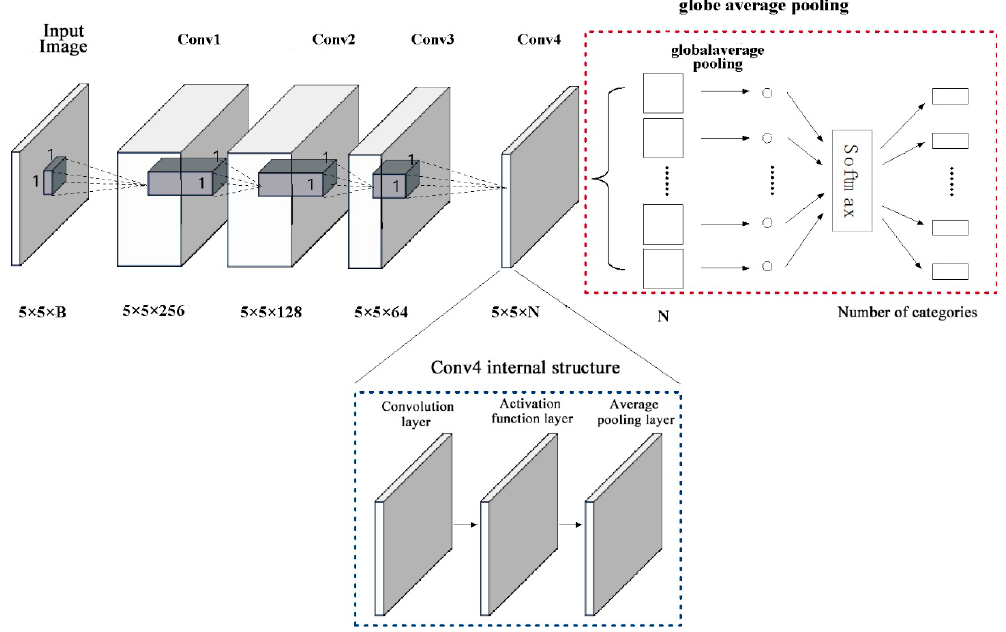
Figure 5. A convolutional neural network model with a global average pooling layer (modified from reference [22]).